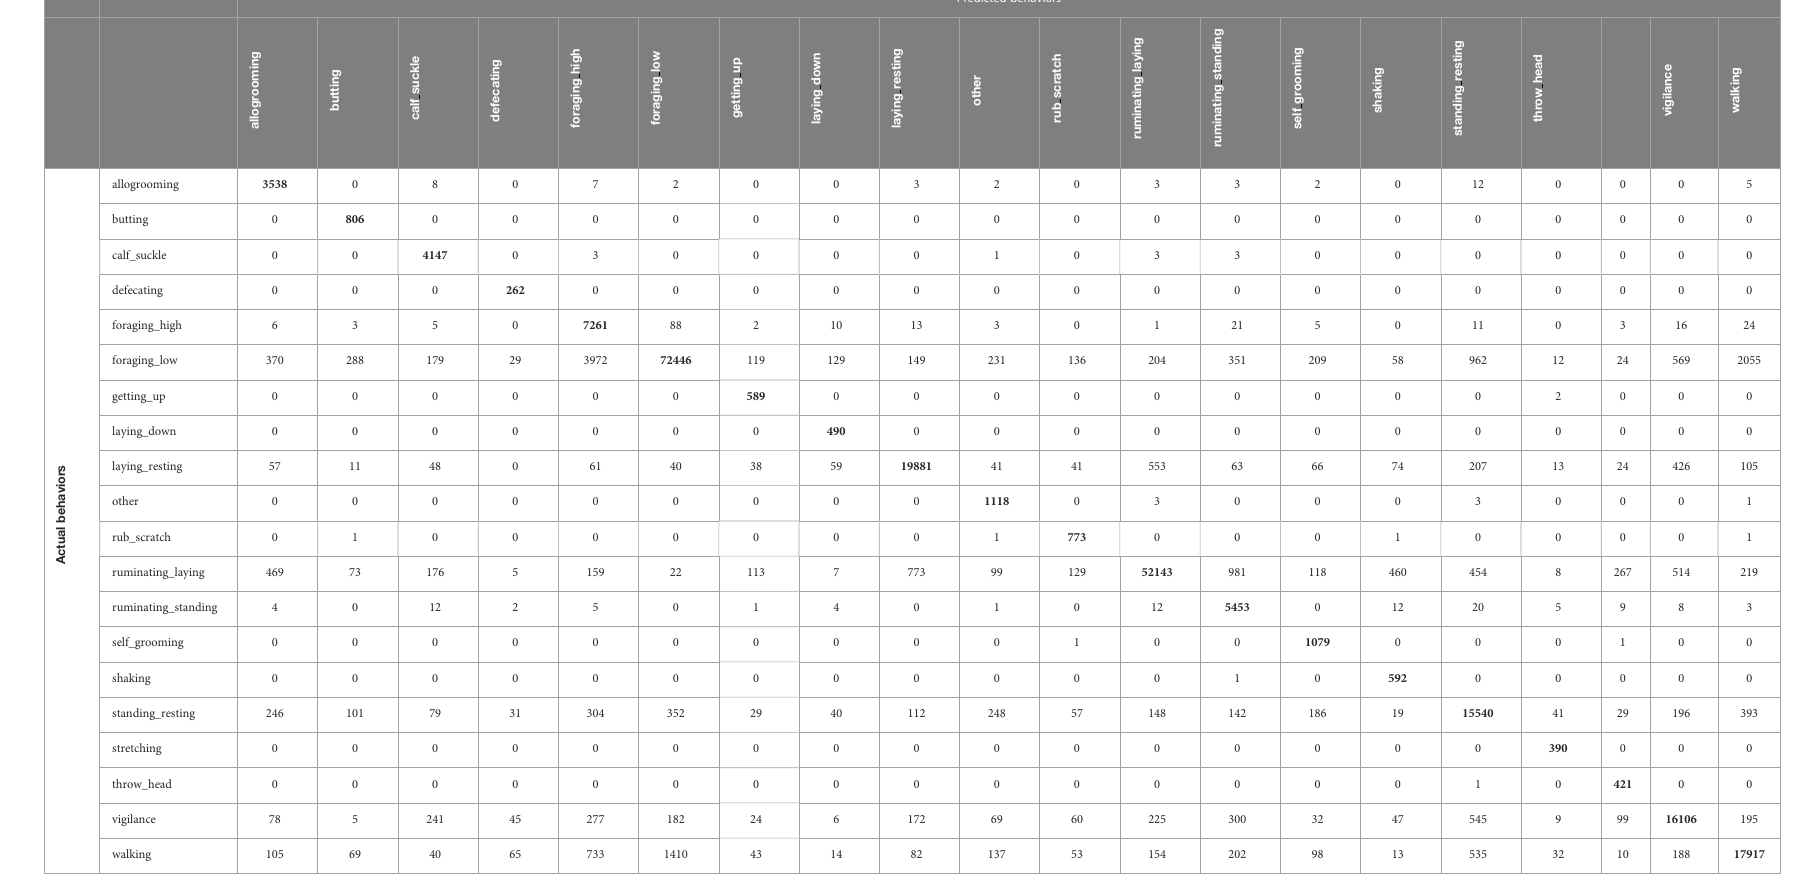
The columns represent the predicted behavior; rows represent the actual observed behavior. Bold values are the number of observations correctly predicted by the